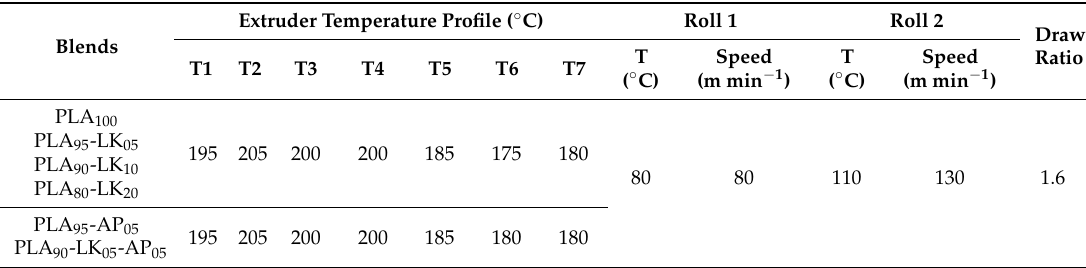
Table 2. Spinning parameters of